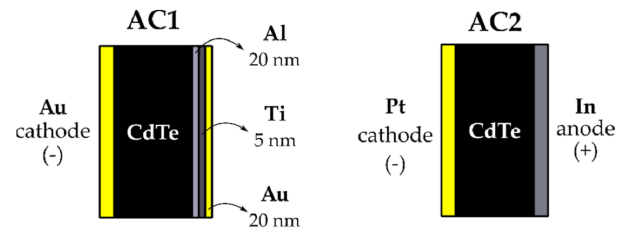
Figure 2. Planar contacts on AC1 ( left ) and AC2 ( right )